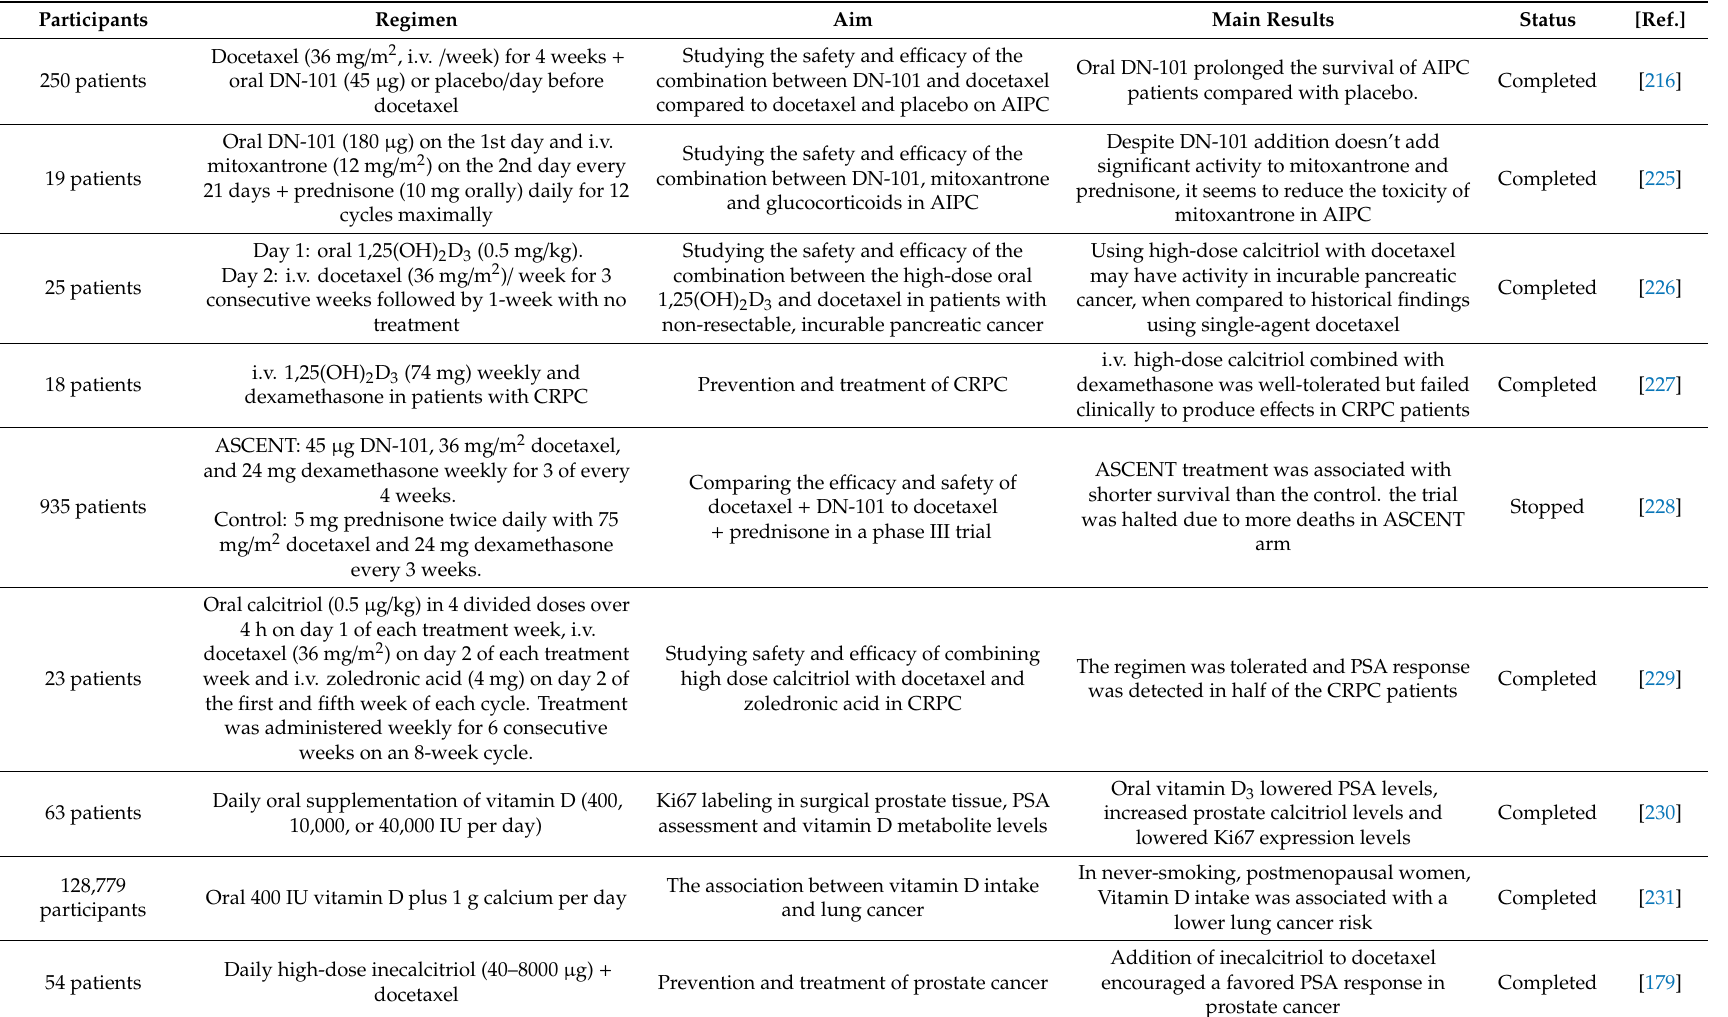
Table 2. Representative clinical trials of vitamin D / vitamin D analogues intake for cancer prevention or